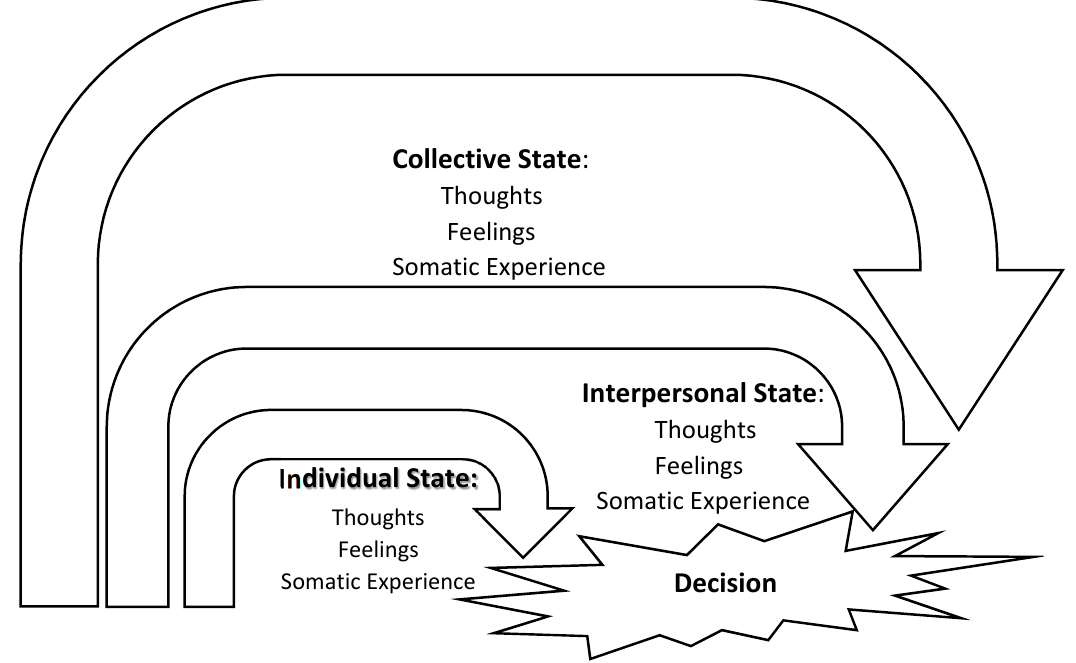
Figure 3. VUCA in action: A dynamic model illustrating how individual, interpersonal, and collective decision-making states are integrated and iteratively impact decisions.